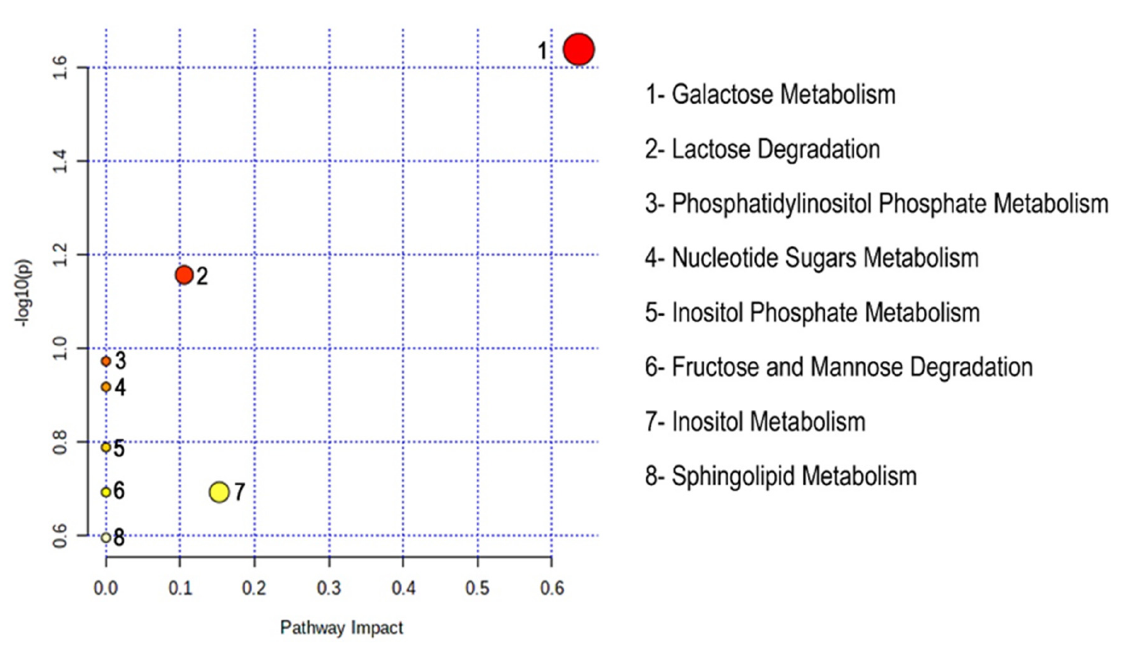
Figure 5. Summary of altered biological pathways in the serum samples affected by β -thalassemia in β -YAC transgenic mice resulting from MetaboAnalyst 5.0 analysis.